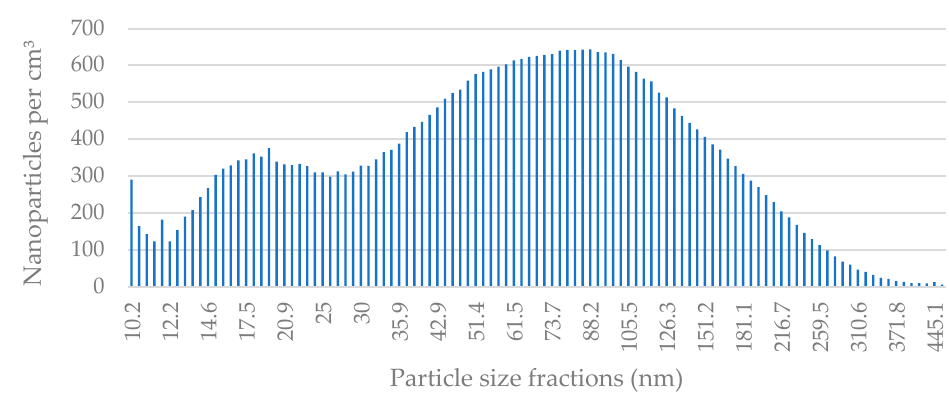
Figure A22. The average nanoparticle concentration in each size fraction in Building 11 during a one-week measurement period during the nonheating season.